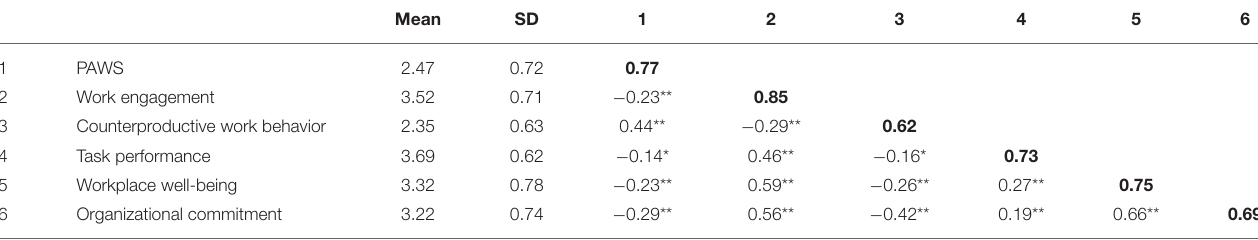
TABLE 5 | Descriptive statistics and correlations in Sample